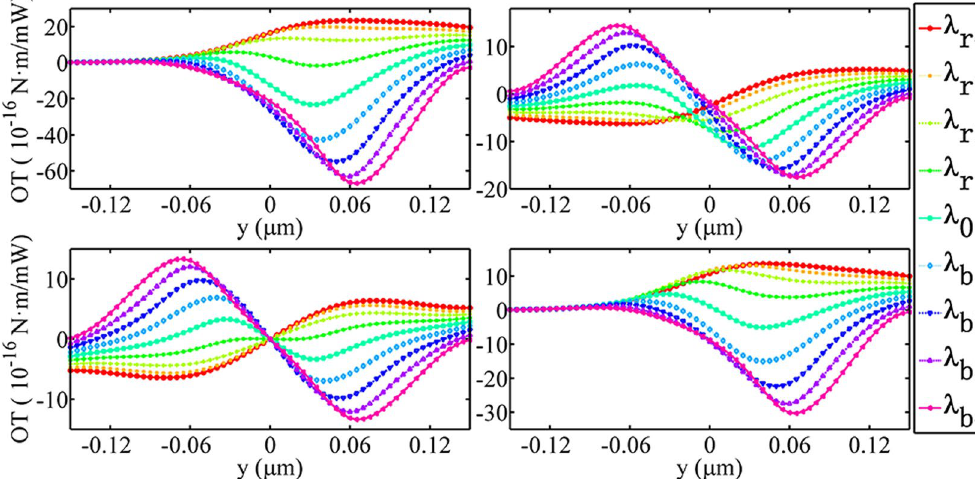
Figure 5. OT versus transverse position y for the four different excitation ways. ( a ) Port 1 is excited. ( b ) Ports 1 & 2 are excited. ( c ) Ports 1 & 3 are excited. ( d ) Ports 1 & 4 are